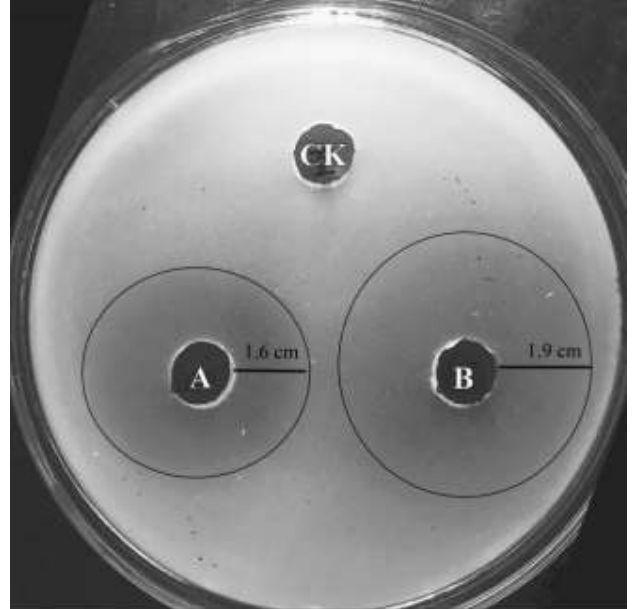
Figure 9. Detection of chitin hydolysis by recombinant proteins on the colloidal chitin medium (1% chitin) CK: 50 µ L supernatant of cell lysate from a strain harboring pET32a (+); A: 50 µ L crude recombinant protein ChiKJ406136 ; B: 50 µ L purified recombinant protein ChiKJ406136. Culturing for 5 d, the diameters of chitin hydrolysis circles were measured. Black circles indicate the area of chitin hydrolysis. Table 1. Quantitative comparison between crude recombinant protein and purified recombinant protein a .